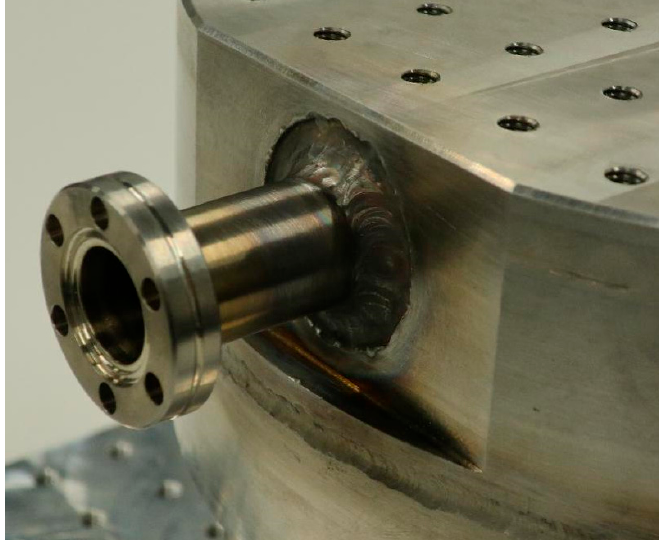
Figure 13. Detail of welding seams between the top and bottom parts of the LN 2 vessel and between the top part of the LN 2 and the connection flange.